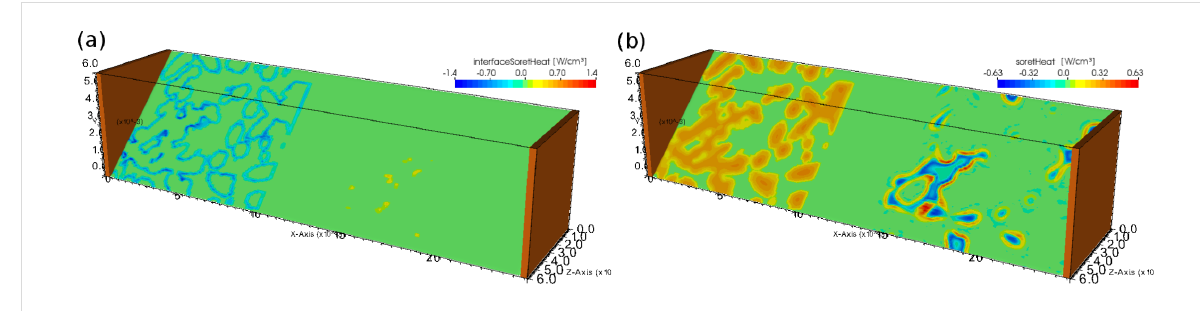
Figure 5: Cut through the ellipsoid-based micro-geometry showing heat production at a normalized capacity of 0.5 by (a) the interface Soret effect and (b) the bulk Soret effect.